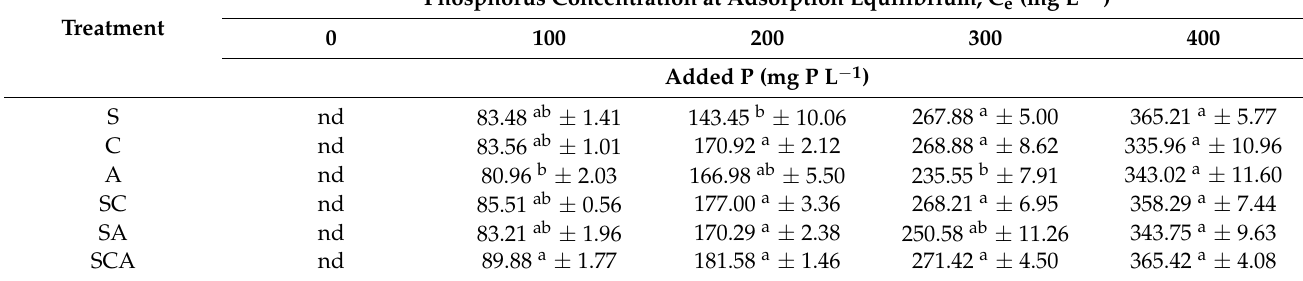
Table 2. Effects of treatments on phosphorus concentration at adsorption equilibrium at different isonormal phosphorus